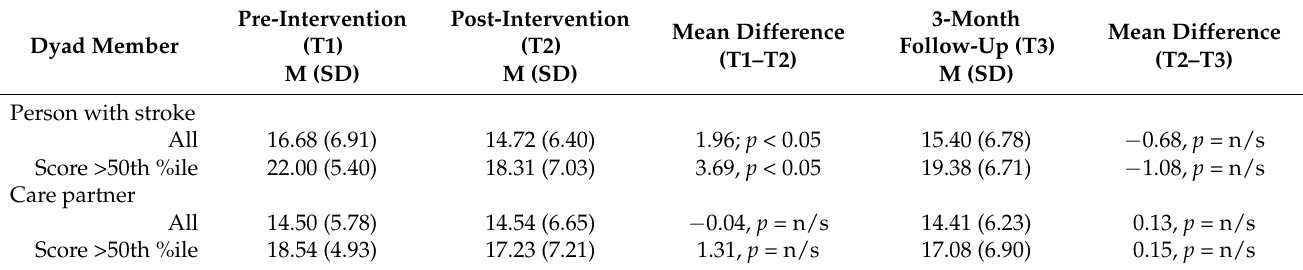
Table 3. Depression scores (PROMIS-D-SF) over time.